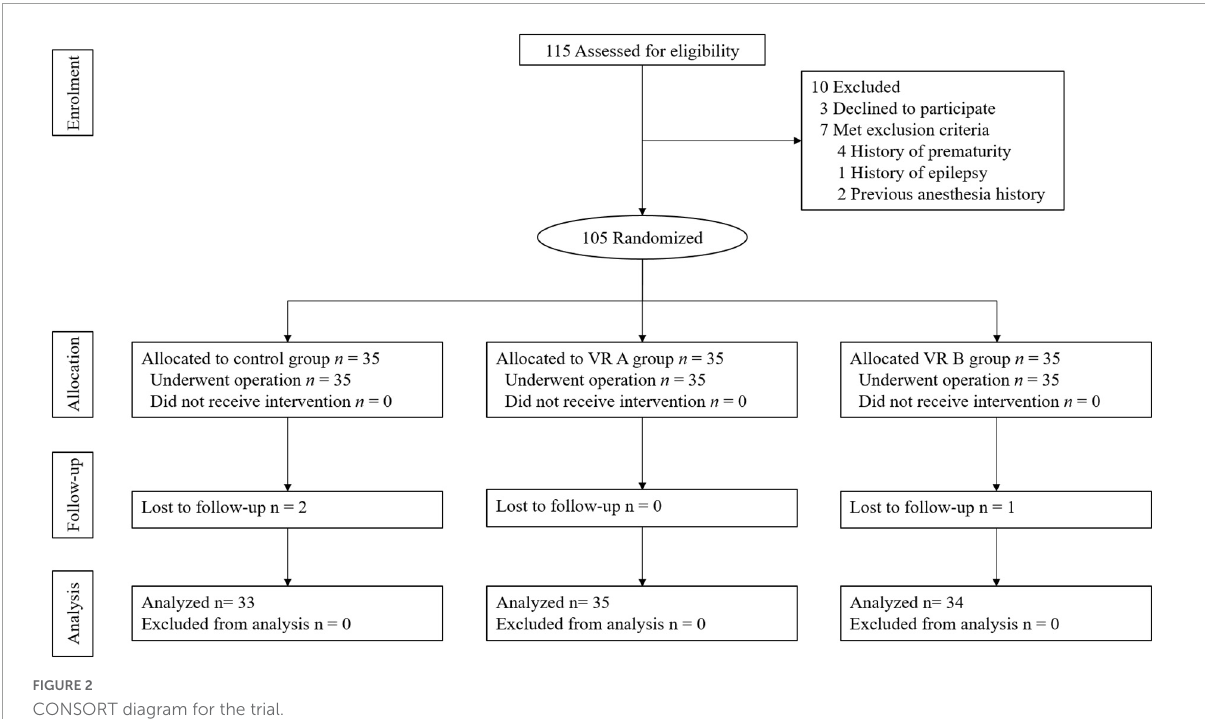
FIGURE2 CONSORT diagram for the